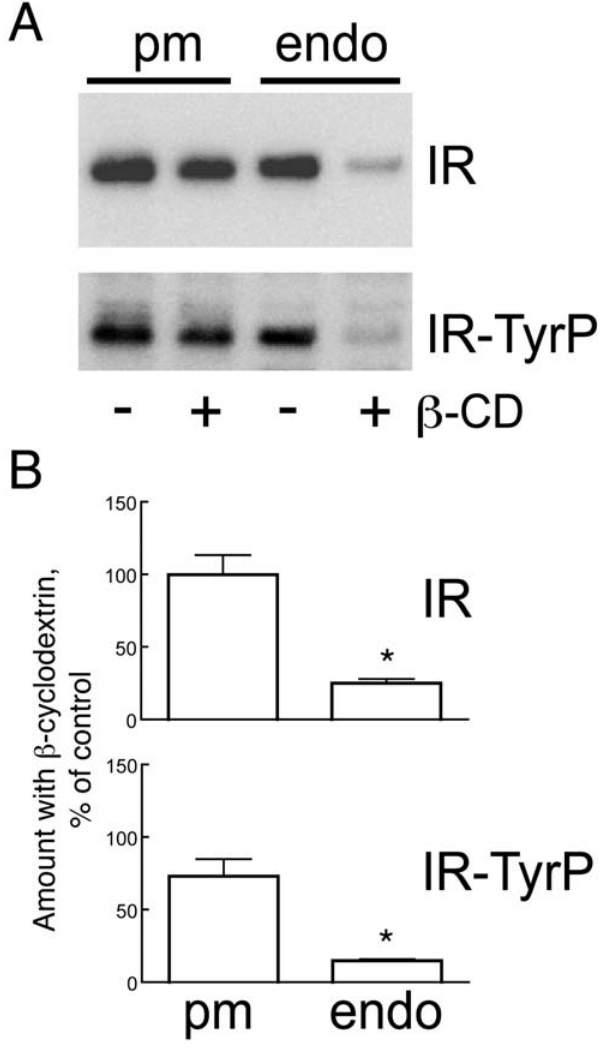
Figure 5. Cholesterol depletion of the cells blocks insulin receptor endocytosis. Isolated adipocytes were incubated with or without 10 mM b -cyclodextrin ( b 2 CD) for 50 min, to deplete the plasma membrane of about 50% of its cholesterol, which completely destroys caveolae while leaving the cells intact [23]. Insulin at 100 nM was added for another 5 min. Cells were then homogenized and plasma membrane (pm) and endosomal (endo) fractions isolated. A . Equal amounts of protein were subjected to SDS-PAGE and immuno- blotting with (from the top) antibodies against insulin receptor b - subunit (IR) or phosphotyrosine (indicated is insulin receptor, IR-TyrP). B . Quantitation of three experiments. Presented as amount of IR or IR- TyrP in the presence of b -cyclodextrin as % of controls without b - cyclodextrin, mean 6 SE. *, p , 0.05 by Student’s t-test.